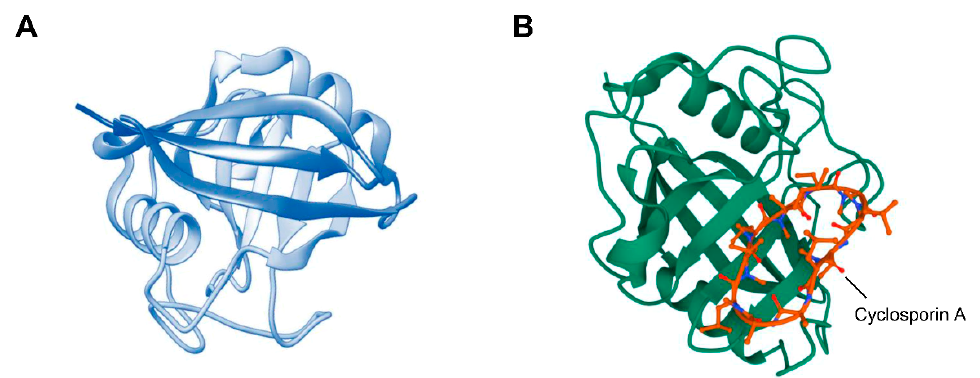
Figure 1. Structure of CypA. ( A ) CypA has an 8-stranded antiparallel β -barrel structure with two α helices surrounding the barrel from either side. ( B ) Structure of CypA-CsA complex. CsA binds to the PPIase active site of